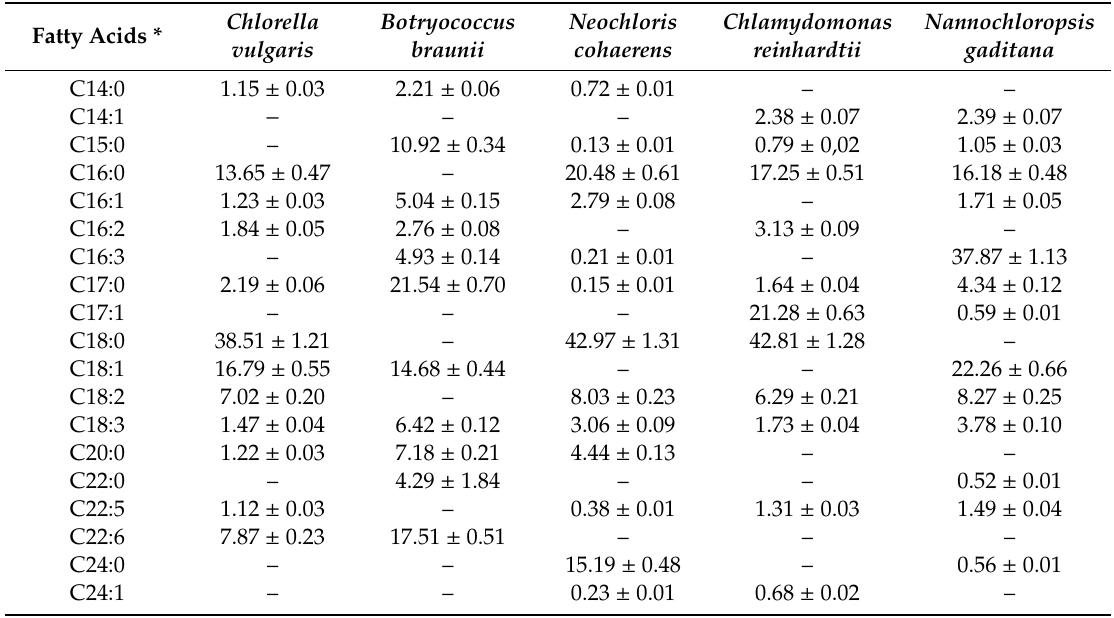
15.19 ± 0.48 0.56 ± 0.01 0.23 ± 0.01 0.68 ±